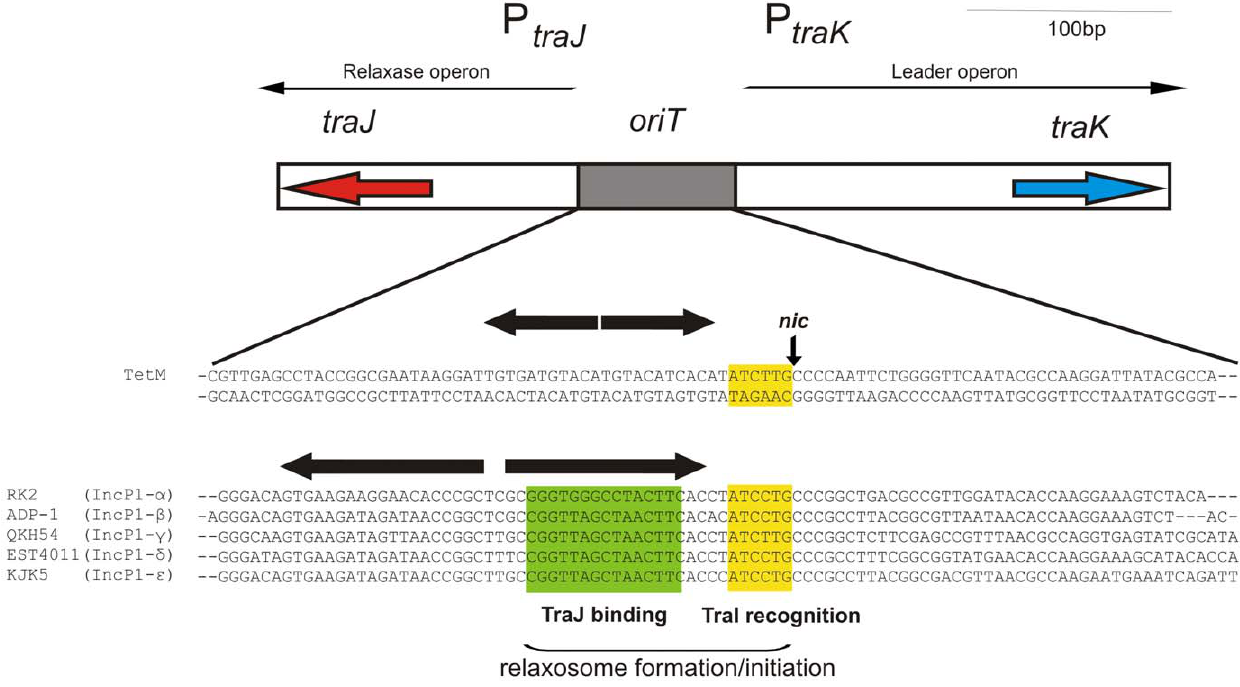
Figure 4. Comparison of the oriT sequences of different members of the IncP1 subfamilies. The common structure of the origin of transfer between the traJ and traK genes of the different IncP1 plasmids is shown. The oriT sequences of the indicted plasmids are depicted. In yellow and green the TraI recognition and TraJ binding sites are indicated. The large horizontal arrows indicate inverted repeat sequences adjacent to the nic site. The small vertical arrow indicates the (putative) nic sites of the relaxases. (The figure is modified from Pansgrau and Lanka (1996))